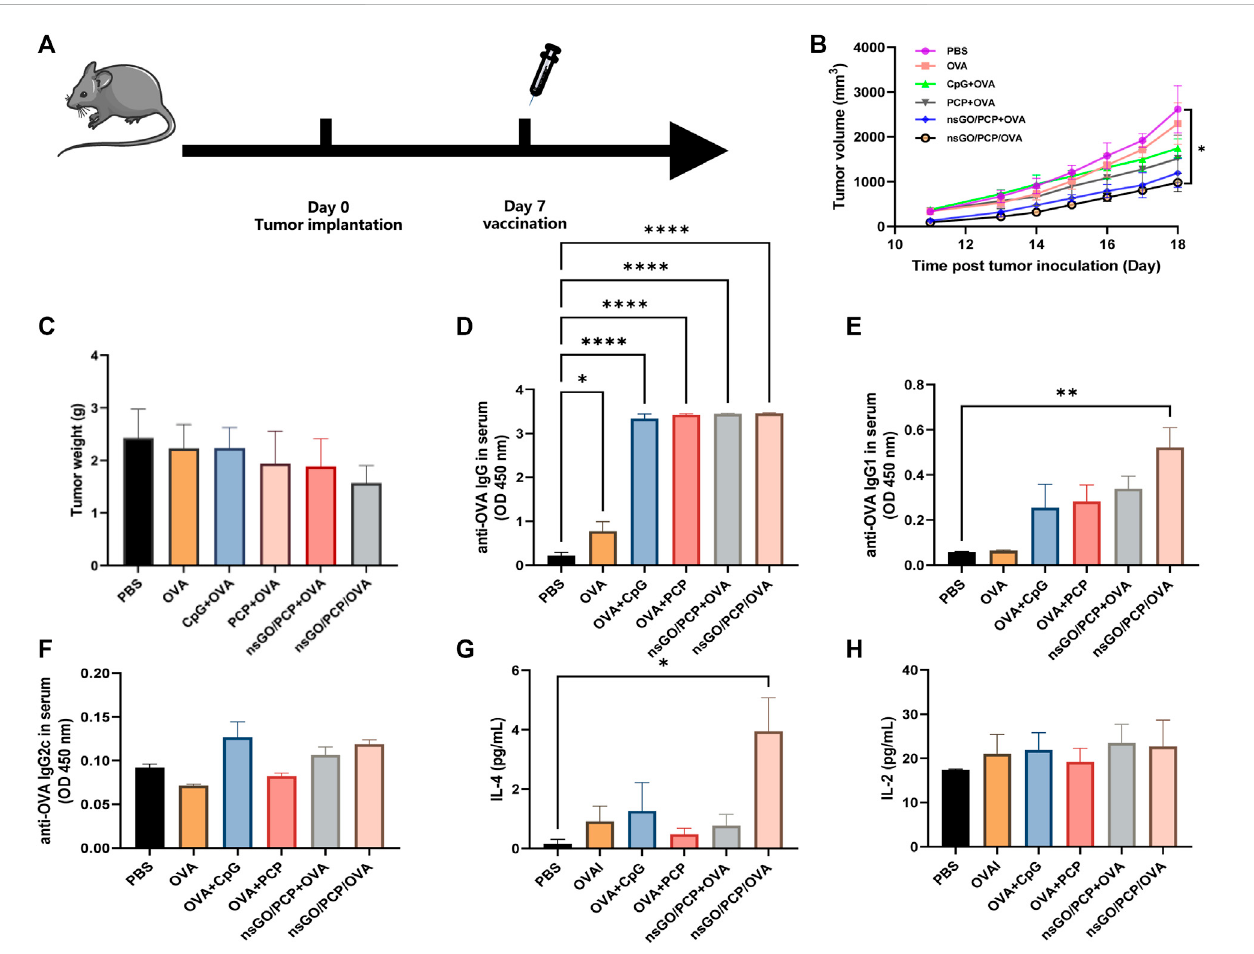
FIGURE 6 Therapeutic anti-tumor effect of nsGO/PCP/OVA on tumor-bearing mice. (A) The scheme of vaccines for tumor treatment. Mice were subcutaneously injectedwith2×10 5 (E) G7-OVAcellsintotheright fl ank.Sevendayslater,themicewereadministeredeitherPBS,OVA,CpG+OVA,PCP+OVA,nsGO/PCP+ OVA, or nsGO/PCP/OVA. Tumor volumes (B) and weight (C) were measured after sacri fi ce on day 18 because the control mice reached a humane endpoint. Blood was collected on day18 from tumor-bearing mice. The concentrations ofOVA-speci fi cIgG (D) , IgG1 (E) and IgG2a (F) secretions in mouse serum were measured by ELISA. Splenocytes were collected on day 18 and cultured with OVA (300 μ g/mL) for 72 h, IL-4 (G) and IL-2 (H) concentrations in the supernatantsofsplenocytesweremeasuredusingELISAkits.Dataarepresentedasmeans±SD(n=5),*, p < 0.05;**, p < 0.01;****, p <